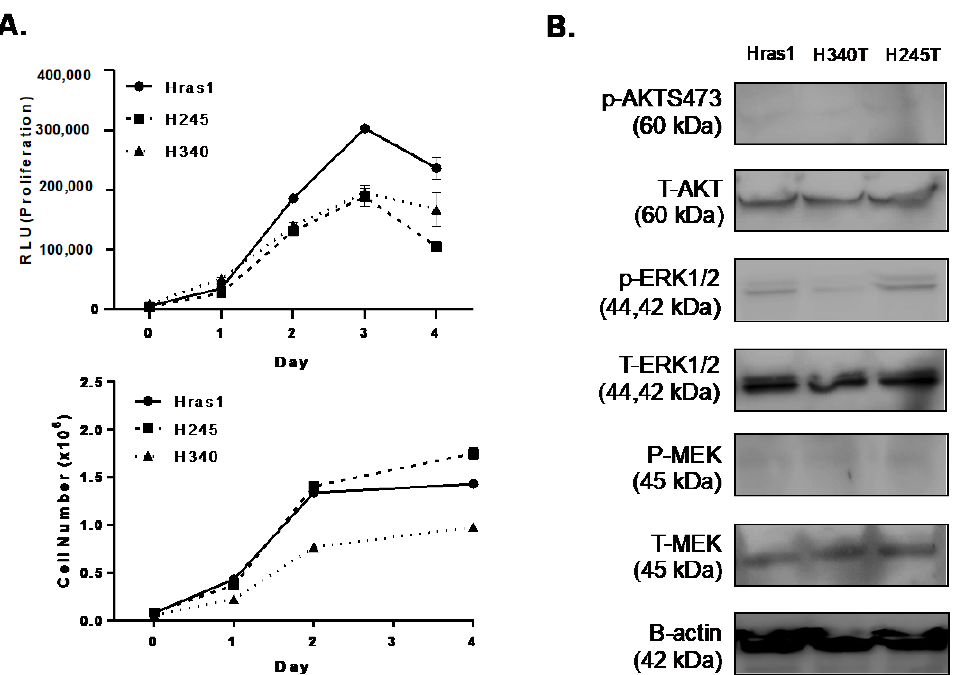
Figure 3. Proliferation rates of thyroid tumor cell lines and activation of MAPK pathway signaling. ( A ) Growth curves of Hras G12V /Pten −/− /TPO-Cre thyroid tumor cell lines (Hras1, H245T, and H340T) . Top: Measurement of proliferation using the Cell-Titer Glo proliferation assay. Bottom: Analysis of proliferation via raw cell counts. Day 0 represents 18 h after plating equal numbers of cells. ( B ) Western blot analysis confirming activation of MAPK pathway signaling in thyroid tumor cell lines. For all data, representative experiments out of 3 are shown. Each sample was analyzed in triplicate ( n = 3). Original blots see Figure S1